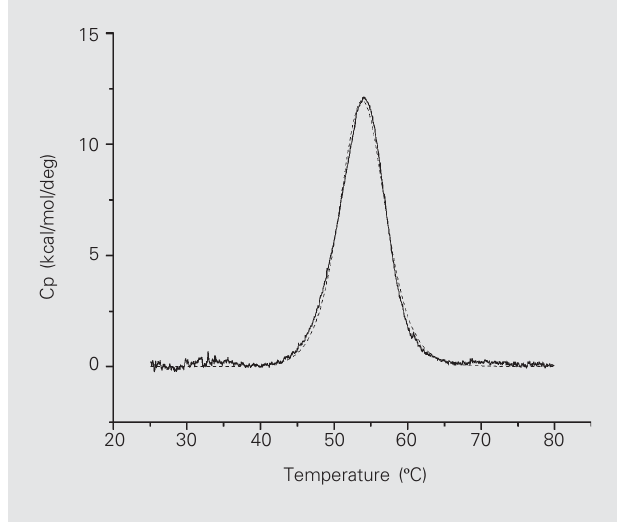
Figure 2. Acid denaturation curve of ß-trypsin. The proteins were 1.0 mg/ ml in 50.0 mM ß-alanine and 20.0 mM CaCl 2 buffer, pH 3.00. Data were obtained by differential scanning calorimetry. The solid line shows data processed after subtraction of the baseline and normalization of protein concentration. The dashed line indicates the fitting of the data to the mathematical model of a two-state transition.